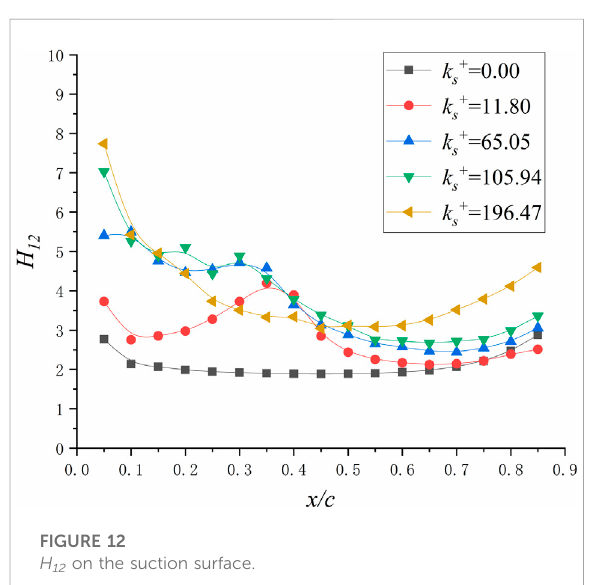
FIGURE 13 Outlet fl ow angle.